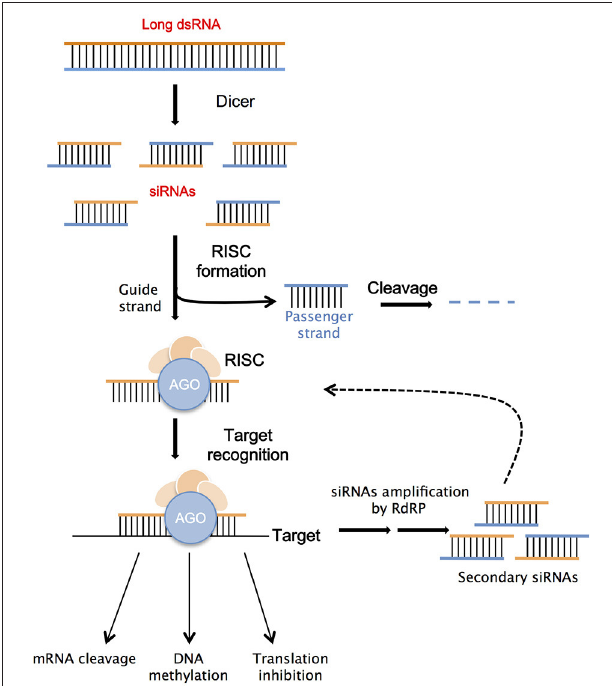
FIGURE 2 | Schematic illustration of RNAi mechanism. Double stranded RNA (dsRNA) molecule binds to a Dicer protein, which cleaves it into small interfering RNAs (siRNAs); these siRNAs bind to an Argonaute (AGO) protein, part of the RNA-Induced Silencing Complex (RISC). The RISC separates the siRNAs into two strands: the passenger strand (blue) is degraded while the guide strand (orange) serves as a search probe, which links RISC to complementary RNA targets. After this recognition target’s expression can be regulated through several different mechanisms. In plants, the silencing signal can be perpetuated by the action of the RNA-dependent RNA polymerase